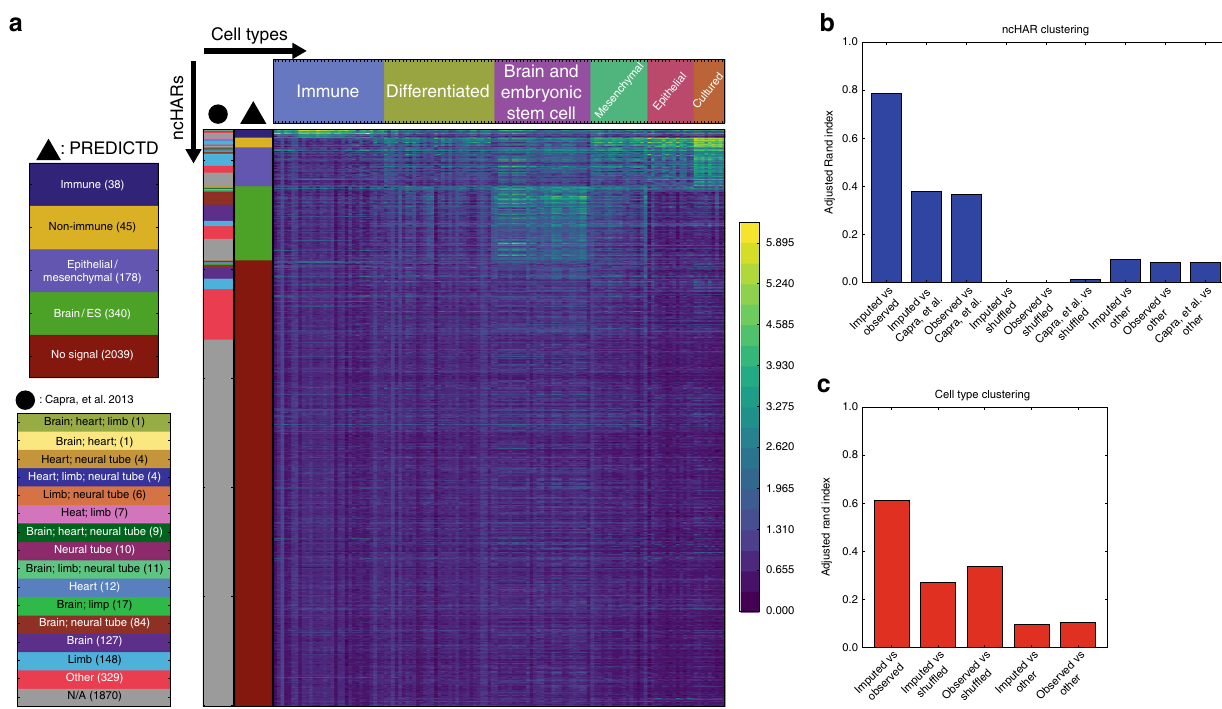
Fig. 5 Imputation of enhancer marks reveals tissue-speci fi c patterns of enhancer-associated marks at noncoding human accelerated regions (ncHARs). a Average PREDICTD signal at each ncHAR was compiled for H3K4me1, H3K27ac, and DNase assays from all cell types. The fi rst principal component with respect to the three assays was used in a biclustering to fi nd six and fi ve clusters along the cell type, and ncHAR dimensions, respectively. The inverse hyperbolic sine-transformed signal from each of these assays was summed per cell type and ncHAR, and the resulting values were plotted as a heat map. The column marked with a black triangle at the top designates the color key for the ncHAR clusters. The leftmost column, designated with a black circle, identi fi es ncHARs with predicted tissue-speci fi c developmental enhancer activity, based on EnhancerFinder analysis from Capra et al. 10 . b and c Evaluation of the clustering results with the adjusted Rand index. The clustering results for observed data and PREDICTD for the ncHAR ( b ) and cell type clusterings ( c ), and also those from Capra et al. 10 for the ncHARs, all show higher adjusted Rand index scores than the clustering results for observed data with shuf fl ed ncHAR coordinates (shuf fl ed) or for observed data from non-enhancer-associated marks